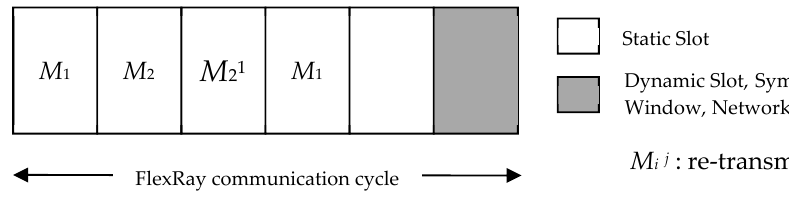
Figure 1. Diagram of message re-transmission mechanism.